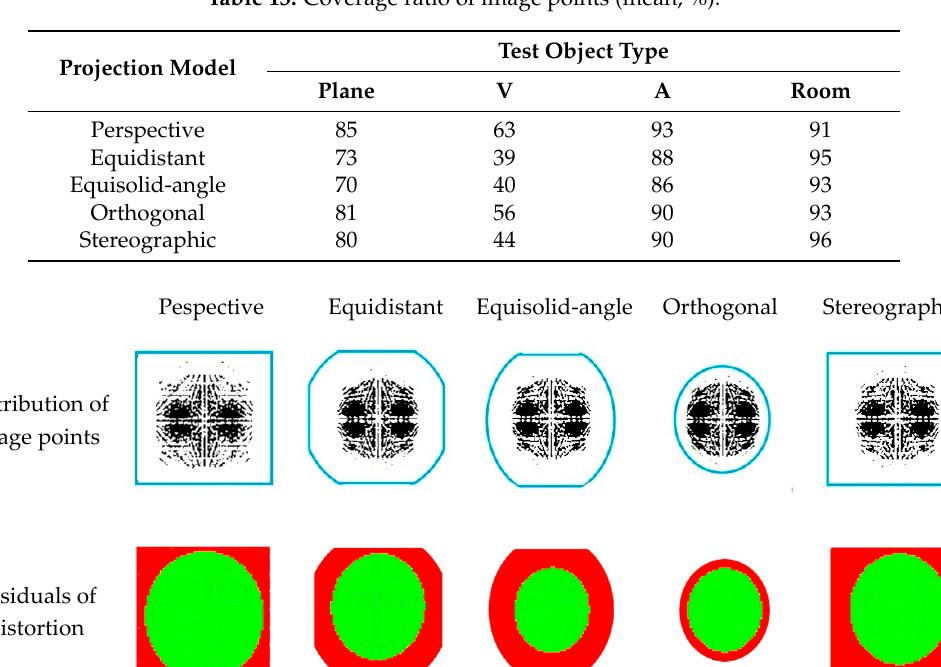
Table 12. RMS-residuals of lens distortion (pixel).